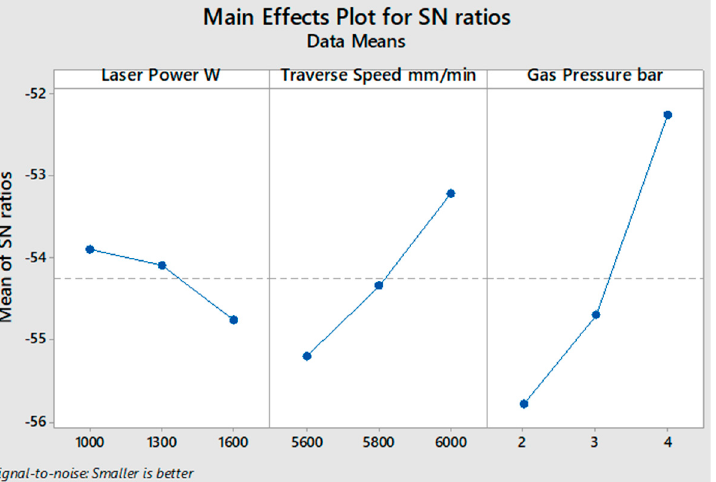
Figure 4. S / N ratio smaller-is-better average value of input cutting parameters of 4 mm thick SPF- UPE. Table 9. ANOVA table for the HAZ response of input cutting parameters of 4 mm thick SPF-UPE.